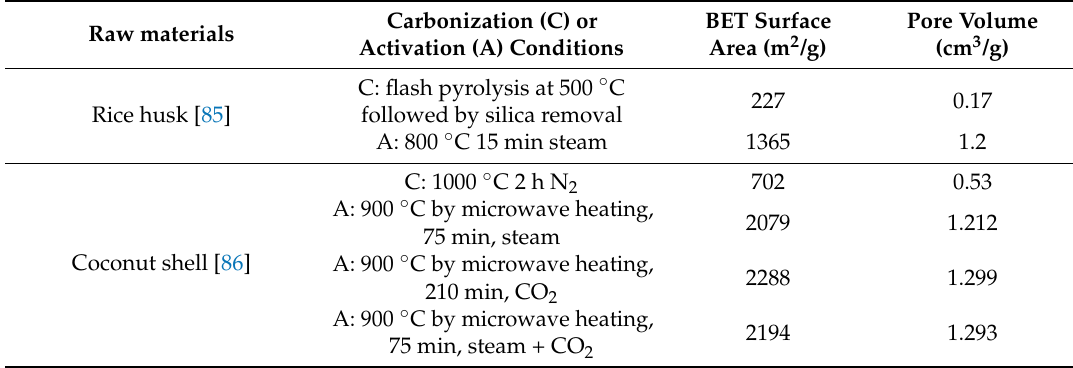
Table 1. The changes in surface area and pore volume of biochar caused by physical activation. BET: